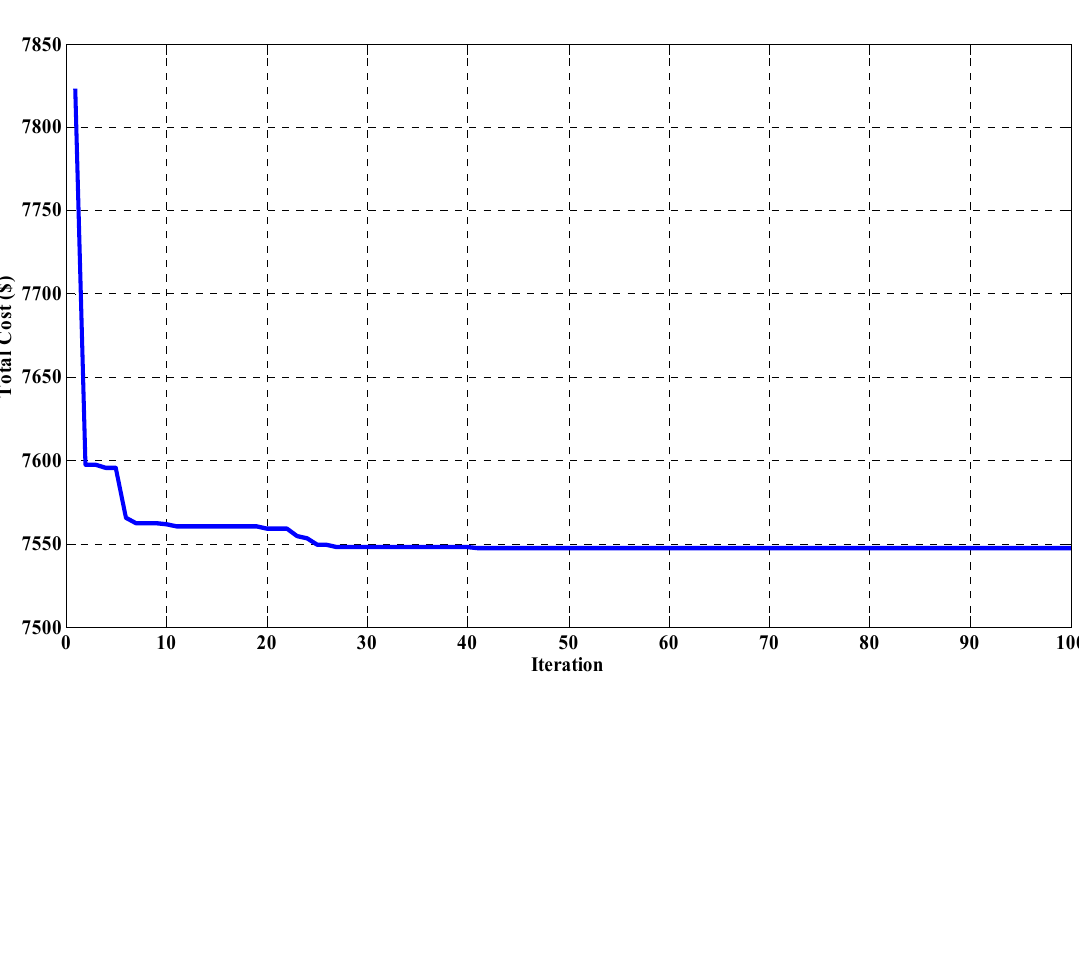
Figure 7. Convergence plot of FAMPSO for cost function considering